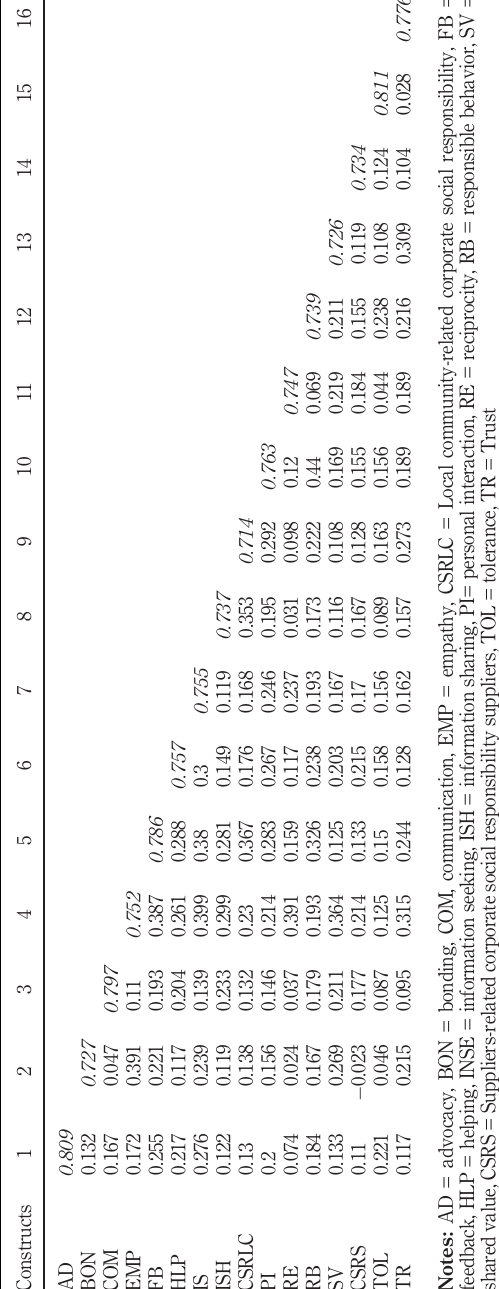
Table 3. Discriminant